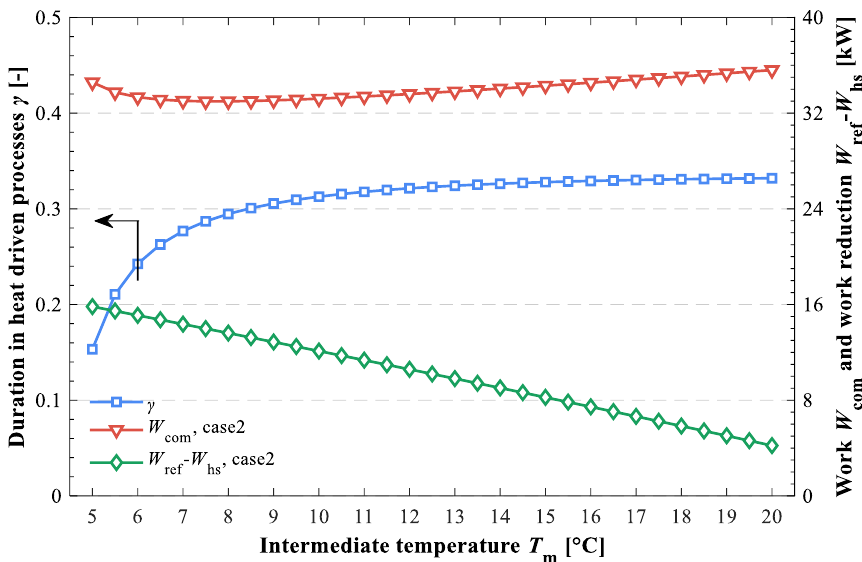
Figure 7. Effect of inter-stage pressure for two-stage cycle with thermal and mechanical compression processes in case 2.